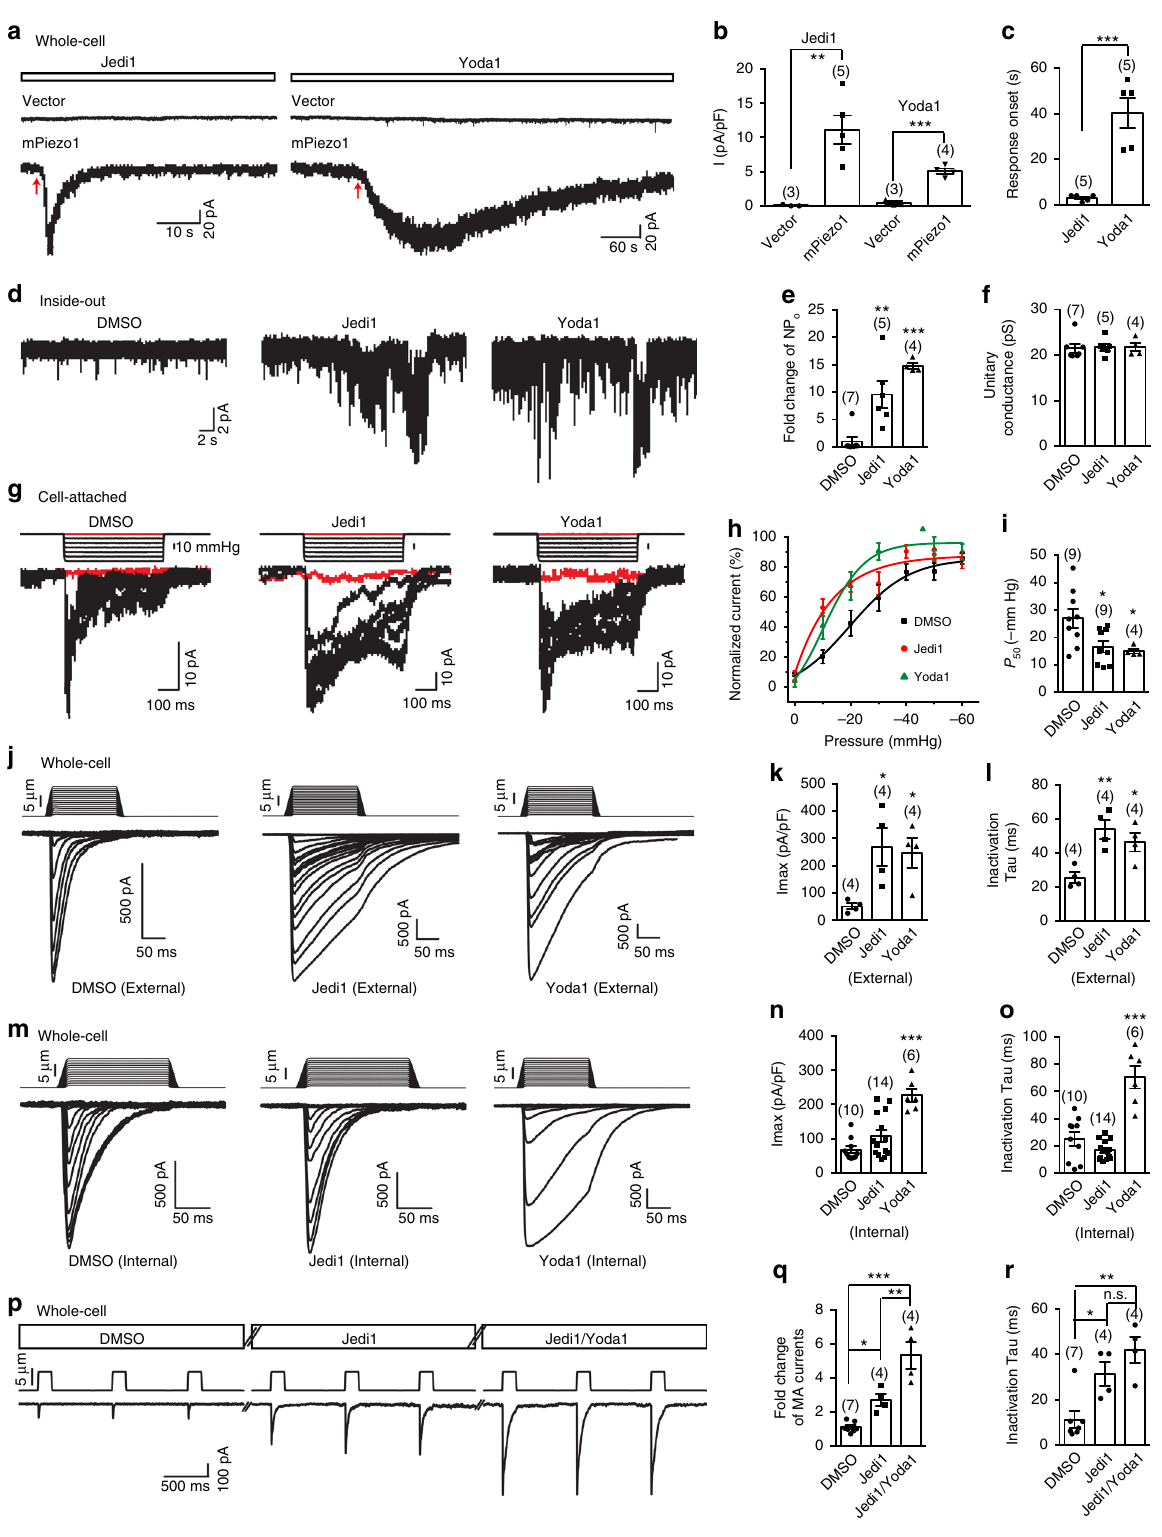
2, the two extracellular loops form key transduction sites for mediating Jedi-induced activation of Piezo1. L1342 and L1345 are required for chemical activation . The L1342A/L1345A mutant has impaired mechanical activation,